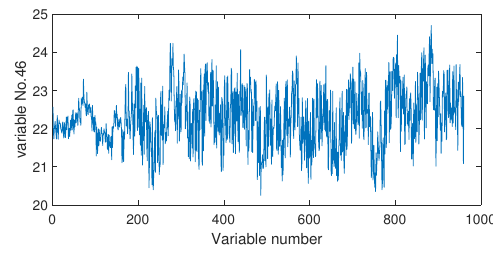
Figure 18. The variable trend (No. 39) when fault F10 occurs.